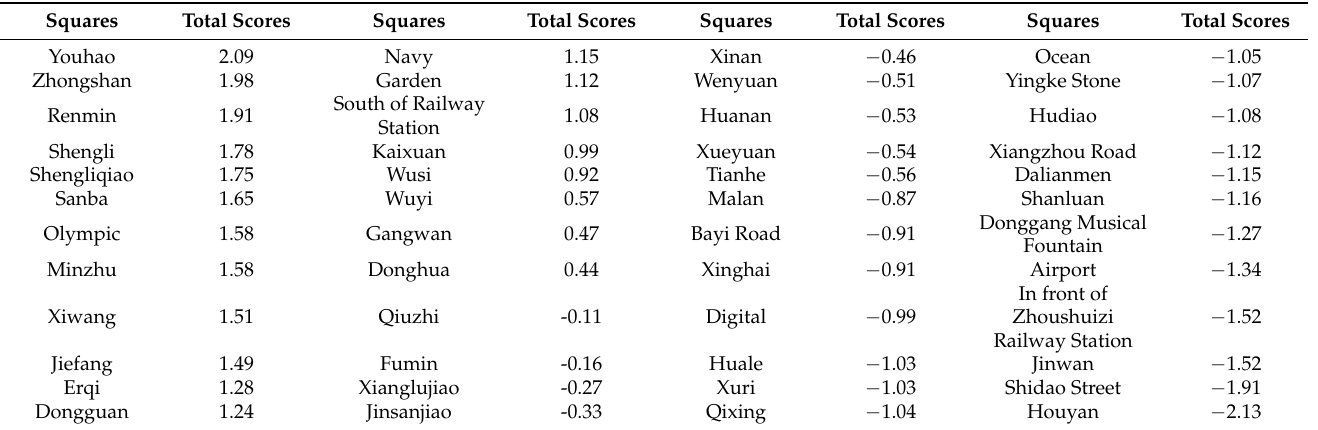
Table 5. Comprehensive evaluation results of city squares (principal component